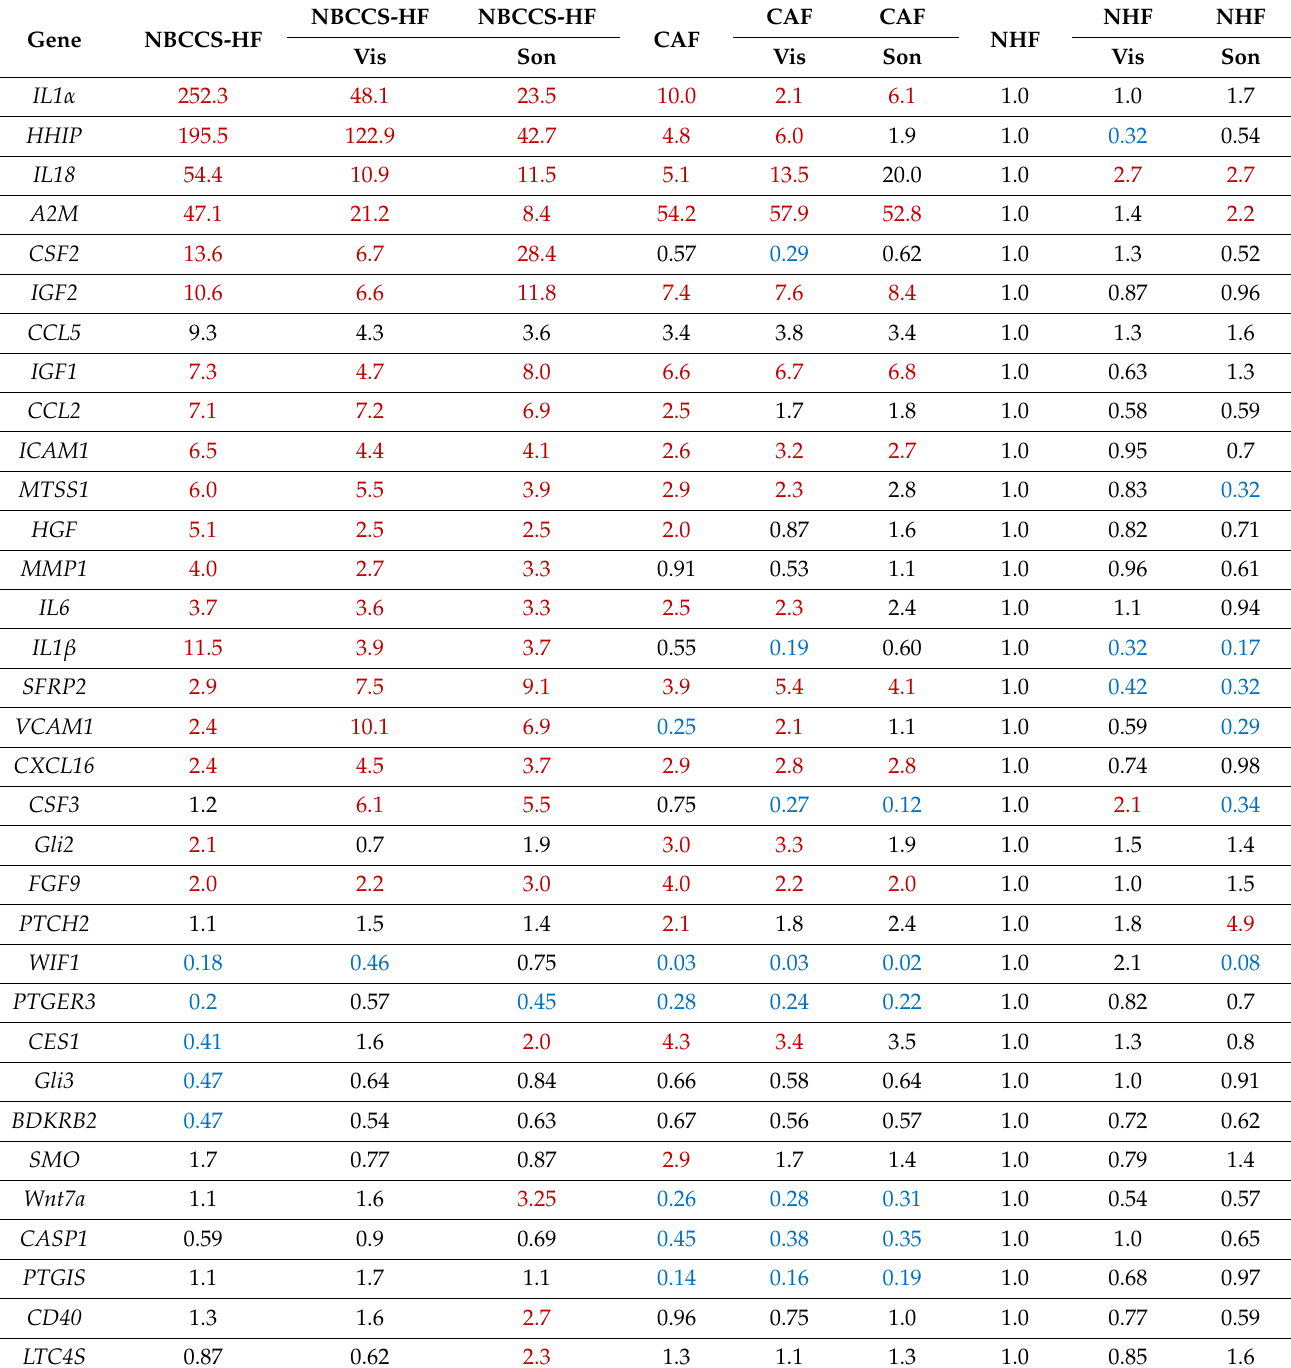
Table 2. Gene expression analysis, 72